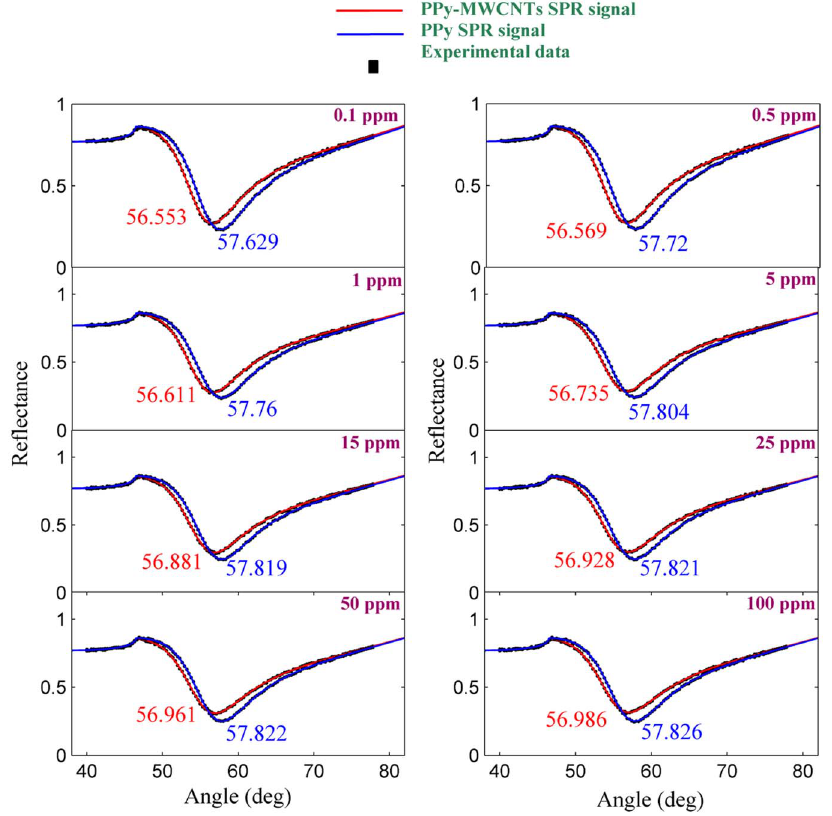
Figure 5. SPR signals for a determination of Pb ion concentration in an aqueous solution at the saturated values.